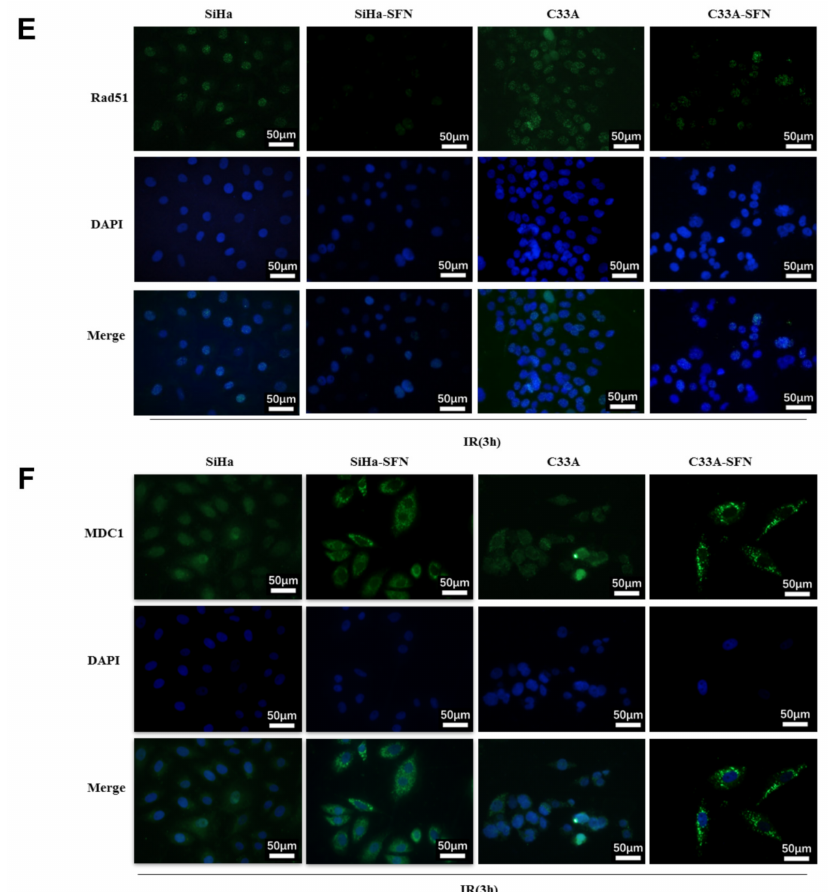
Figure 3. SFN enhances radiosensitivity in vitro by inhibiting RAD51 and MDC1 nuclear recruitment. ( A ) Colony formation of SiHa and C33A cells treated with SFN (10 and 7.5 uM, respectively) or control after irradiation. After 2 weeks of incubation, colonies with more than 50 cells were produced. ( B ) Kaplan–Meier plot of survival days of mice with SFN treatment (25 uM) and control group after IR exposure (8 Gy) ( C ) Tumors of mice injected with SiHa cells were removed 2 weeks after injection. ( D ) Immunofluorescence analysis of DNA damage according to the presence of γ -H2AX in SiHa and C33A cells treated with SFN (15 and 10 uM, respectively), 24 h after irradiation. Western blotting was conducted to quantify γ -H2AX protein levels 24 h after being subjected to IR. Cropped blots were showed in Western blotting. The samples derived from the same experiment and those blots were processed in parallel. ( E , F ) Representative immunofluorescence images of Rad51 and MDC1 nucleus foci formation 3 h after irradiation comparing cells with SFN treatment and control. ** p <